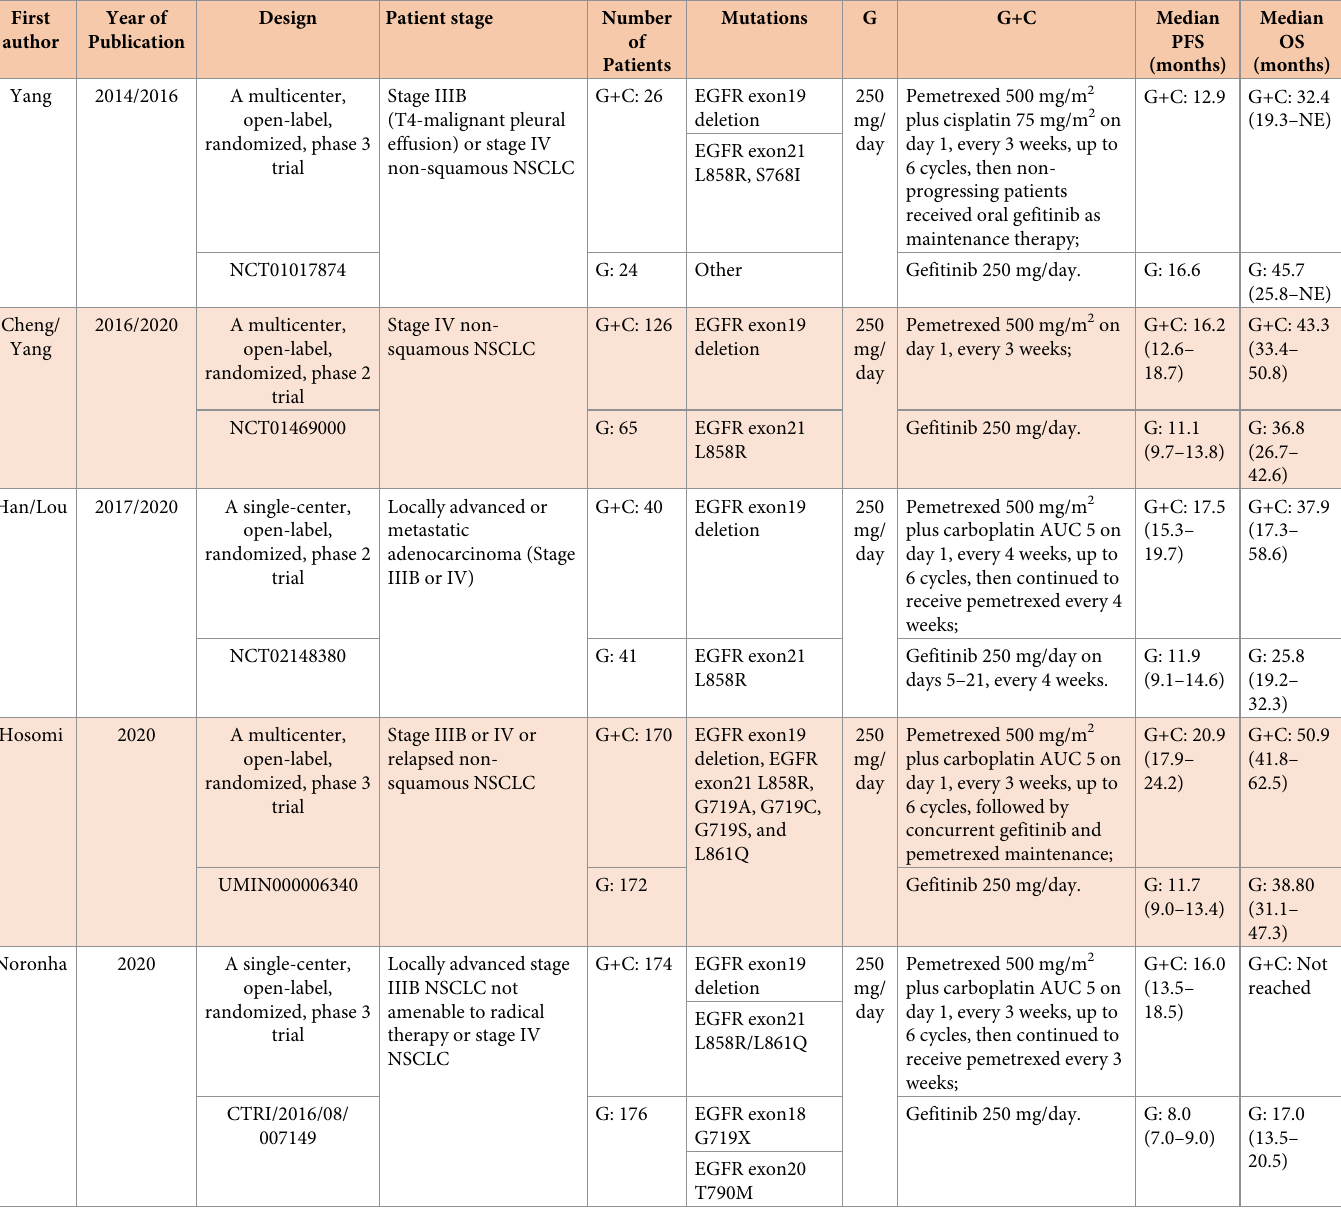
Table 1. Basic characteristics of enrolled trials and survival